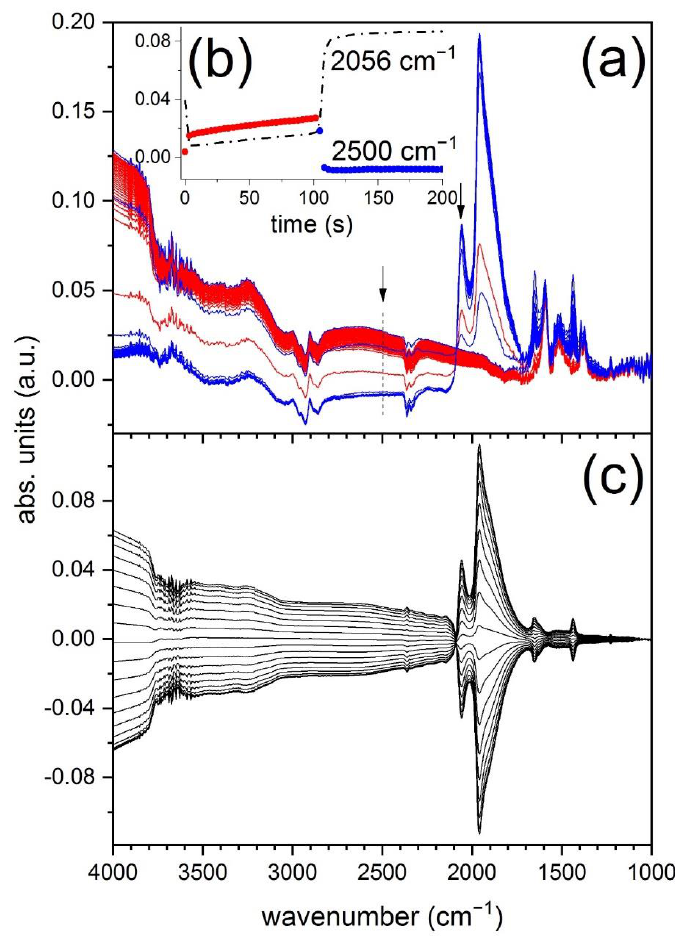
Figure 2. ( a ) Averaged time-resolved DRIFT spectra of 1 wt.% Pd/Al 2 O 3 during a O 2 /CO modulation period at 300 ◦ C. Arrows indicate the two signals at 2500 cm − 1 (baseline) and 2056 cm − 1 (CO L ) whose temporal dependence is shown in ( b ). O 2 pulse, red spectra; CO pulse, blue spectra. ( c ) Corresponding phase-resolved DRIFT spectra.